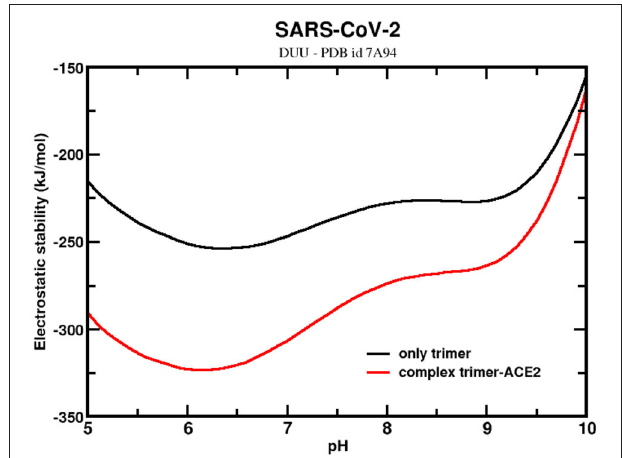
FIGURE 7 | Simulated electrostatic stability profiles for the SARS-CoV-2 wt spike homotrimers at two different ACE2-bound forms as a function of pH. The continuous black line refers to SARS-CoV-2 wt at the apo state (maintaining the same conformation of the complex), and the red line refers to the complex trimer-ACE2. The three-dimensional coordinate was given by the PDB id 7A94. Salt concentration was fixed at